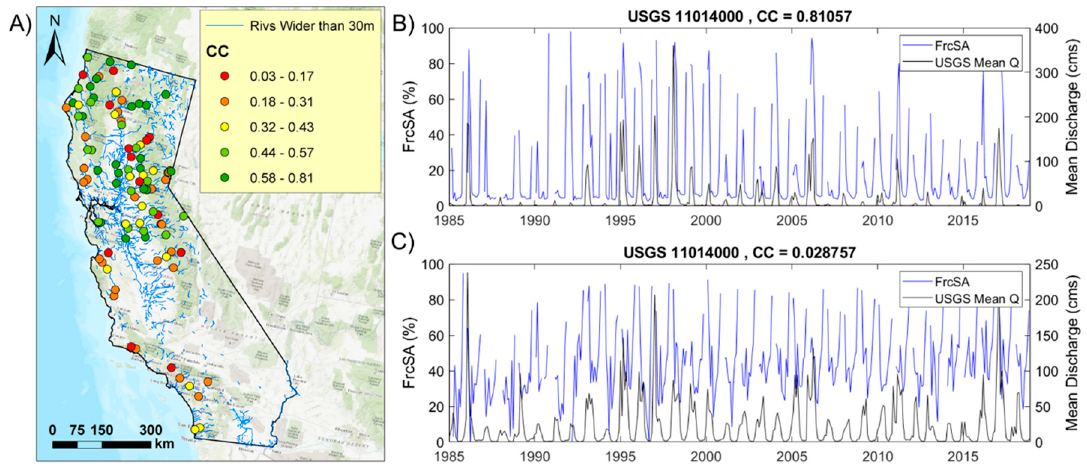
Figure 4. Correlation coefficients of monthly FrcSA and monthly mean streamflow at co-located 187 USGS gauges ( A ), the time series at the gauges with the highest ( B ) and lowest ( C ) correlations.